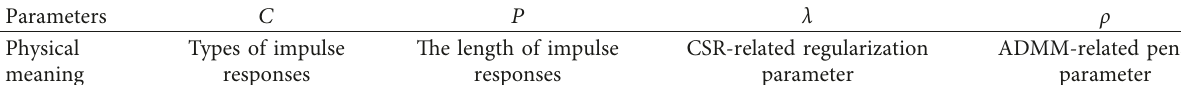
Table 2: Signal feature-related parameters.